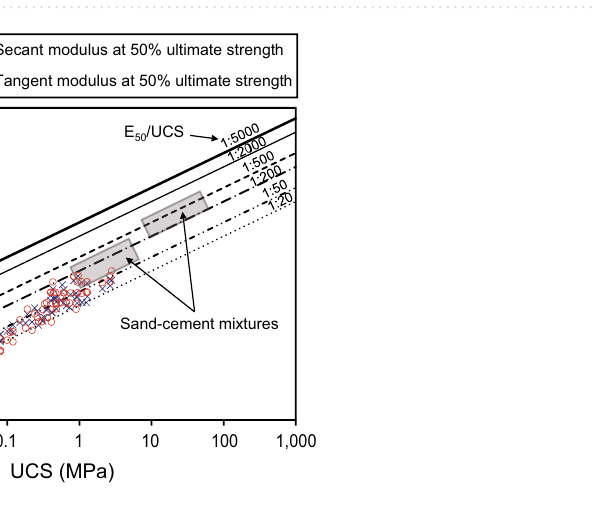
Figure 17. Relationships between ( a ) the secant modulus at 50% ultimate strength (E s50 ) and ( b ) the tangent modulus at 50% ultimate strength (E t50 ) and unconfined compressive strength with respect to three levels of breccia content (0, 20, and 40 wt.%).